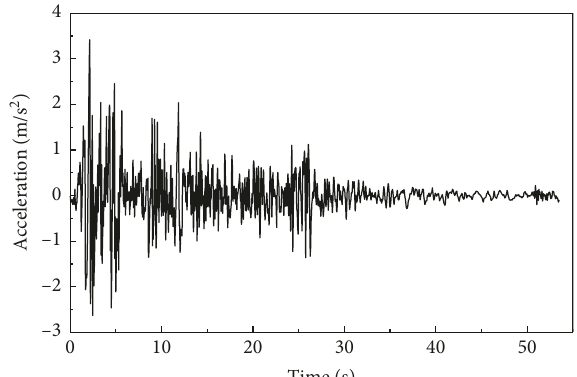
Figure 1: Acceleration and time curve of El Centro wave.